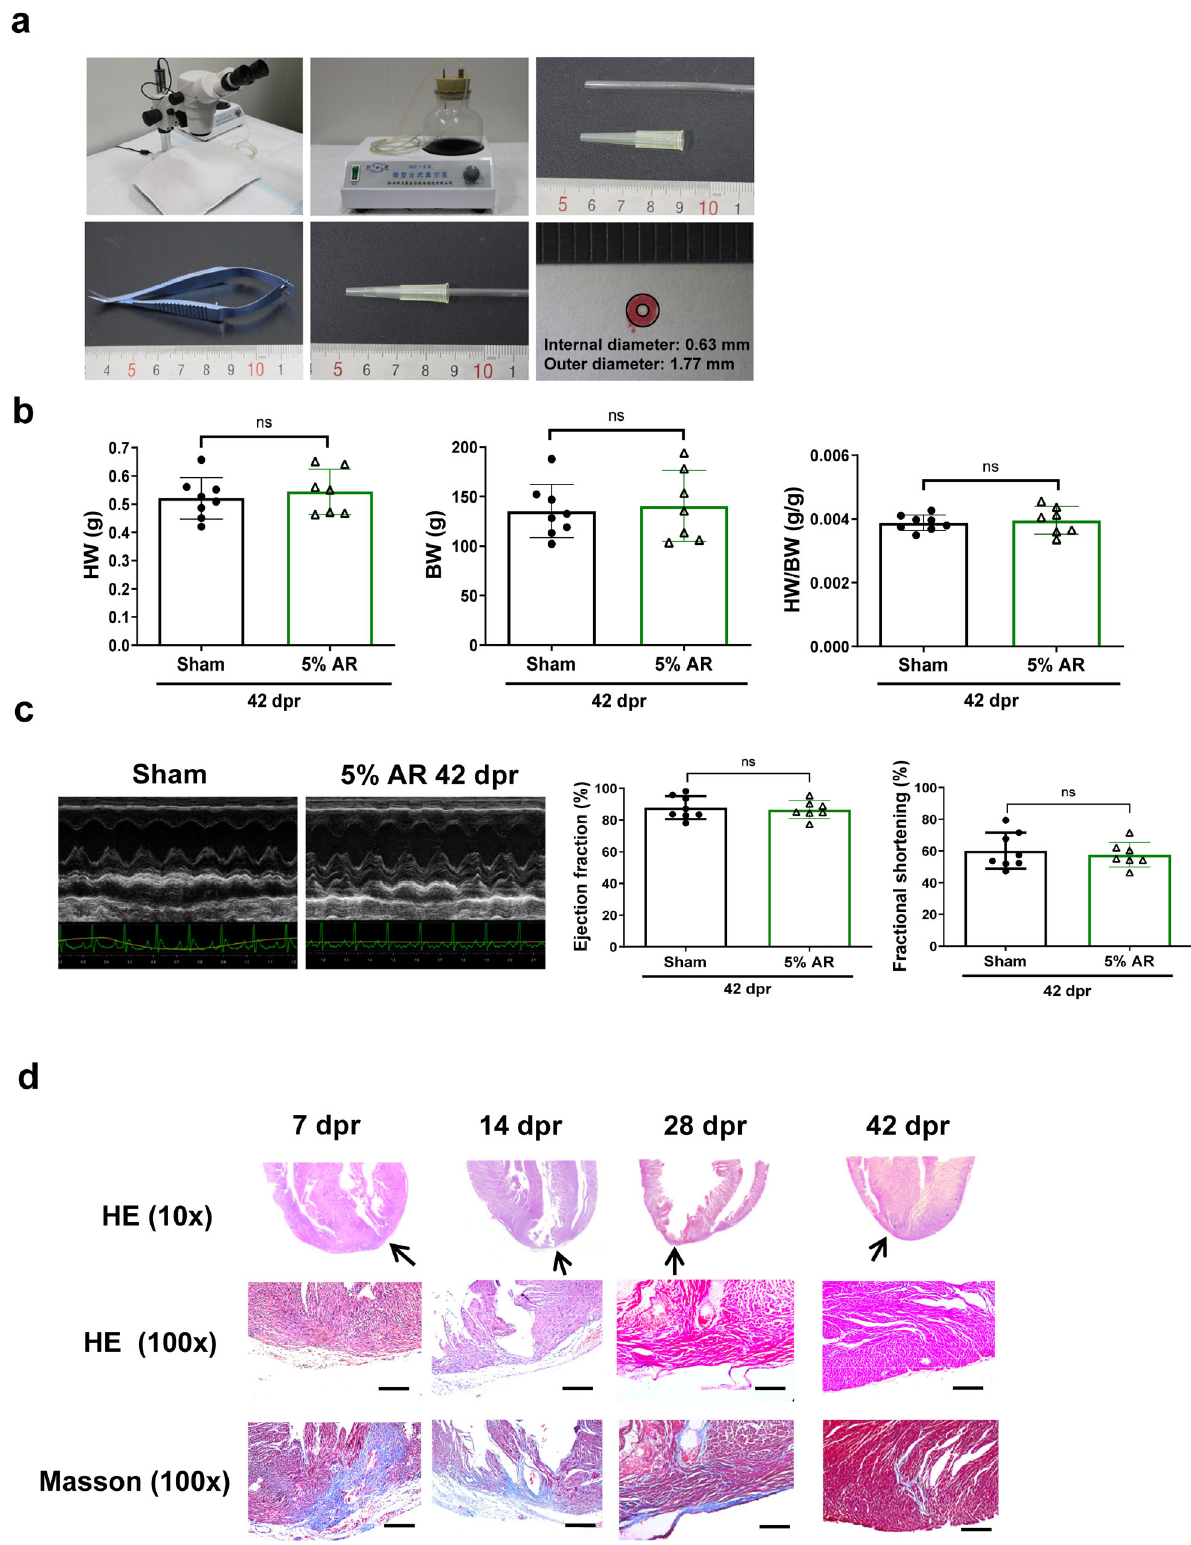
Fig. 5 Cardiac structural and functional recovery after 5% modi fi ed apical resection surgery in 1-day-old neonatal rats. a A stereoscope, a desktop vacuum pump, and a 200 μ L pipette tip with its tip cut to 0.63 mm in internal diameter using a sharp blade, were prepared for modi fi ed apical resection (AR) method. b Heart weight (HW), body weight (BW), and heart weight/body weight ratio (HW/BW) at 42 days post resection (dpr) ( n = 7-8). c Echocardiography for left ventricle ejection fraction and fractional shortening at 42 dpr ( n = 7-8). d Representative images for hematoxylin-eosin (HE) and Masson ’ s trichrome staining for AR hearts at 7, 14, 28, and 42 dpr. Scale bar = 200 μ m. ns not signi fi cant. All data are expressed as means ±